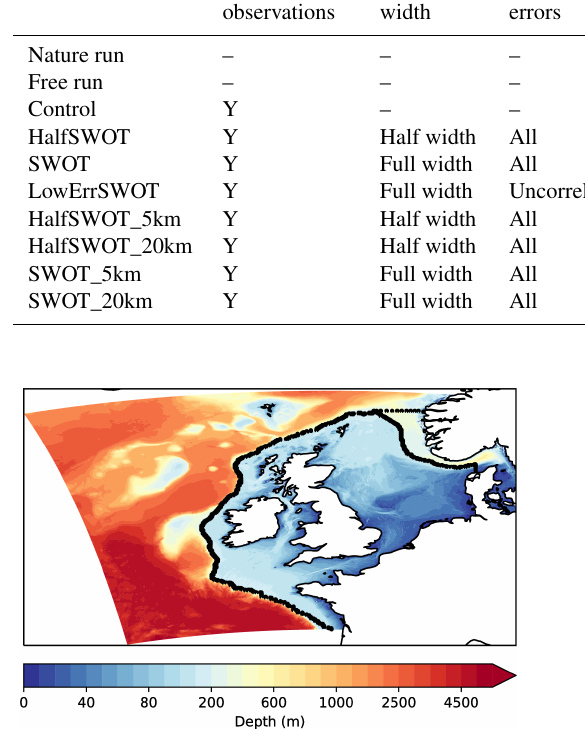
Figure 1. The bathymetry of the 1.5km resolution North West Eu- ropean shelf system. The boundaries between the off-shelf, on-shelf and Norwegian Trench regions are marked by a black line. Note that a non-linear colour scale has been used to highlight the complex